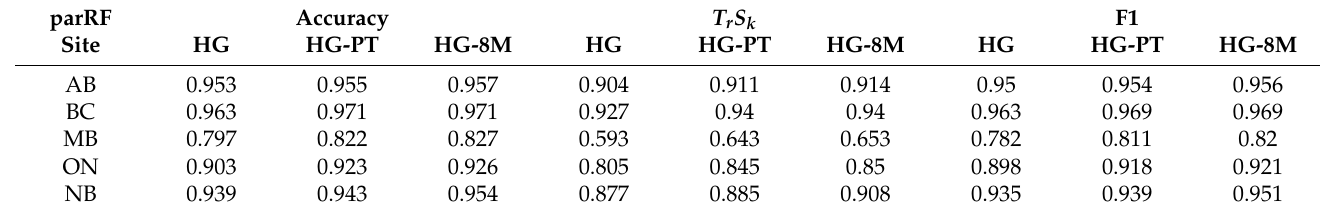
Table 2. Results of the parRF model for each study area.